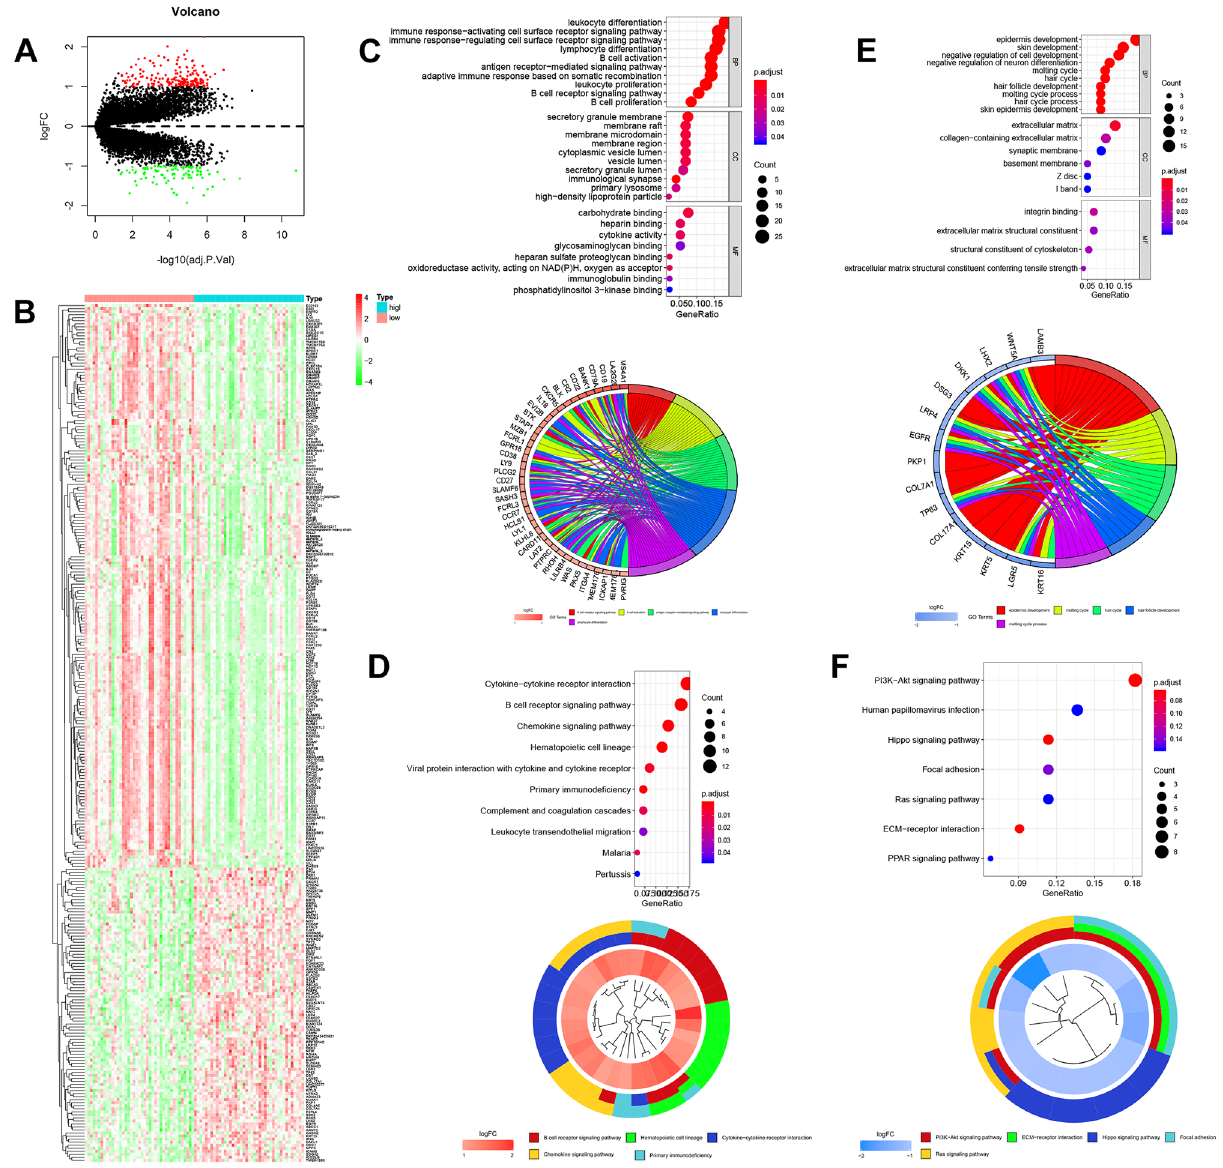
Figure 7. The risk status of DEGs. ( A ) The volcano map from DEGs with different risk status. ( B ) The DEGs heatmap form the different risk-status. The functional enrichment of DEGs, including GO ( C,E ) and KEGG ( D,F ) analysis using R packages “clusterProfiler” and